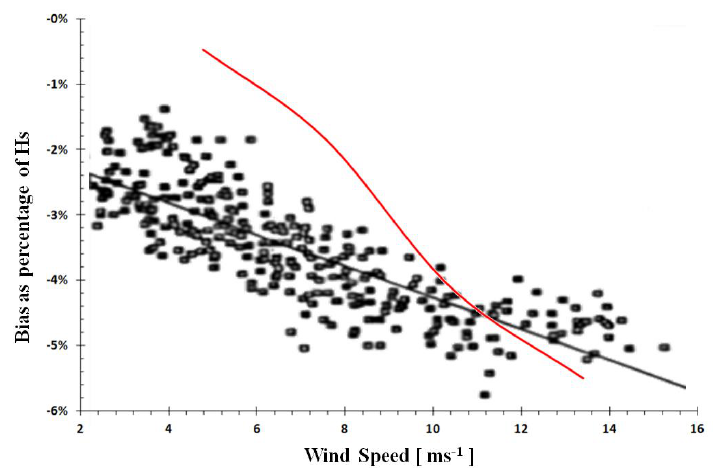
Figure 11. Comparison between FISSB as function of Hs through simulated foam effect (present paper) and Melville et al. [24] experimental SSB (modified